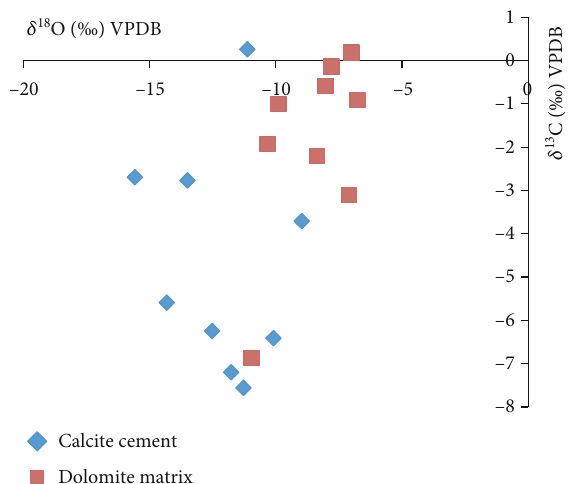
Figure 6: Cross-plot of δ 18 O vs. δ 13 C values of calcite cement and dolomite matrix of Yican 1 well in the southeastern Ordos